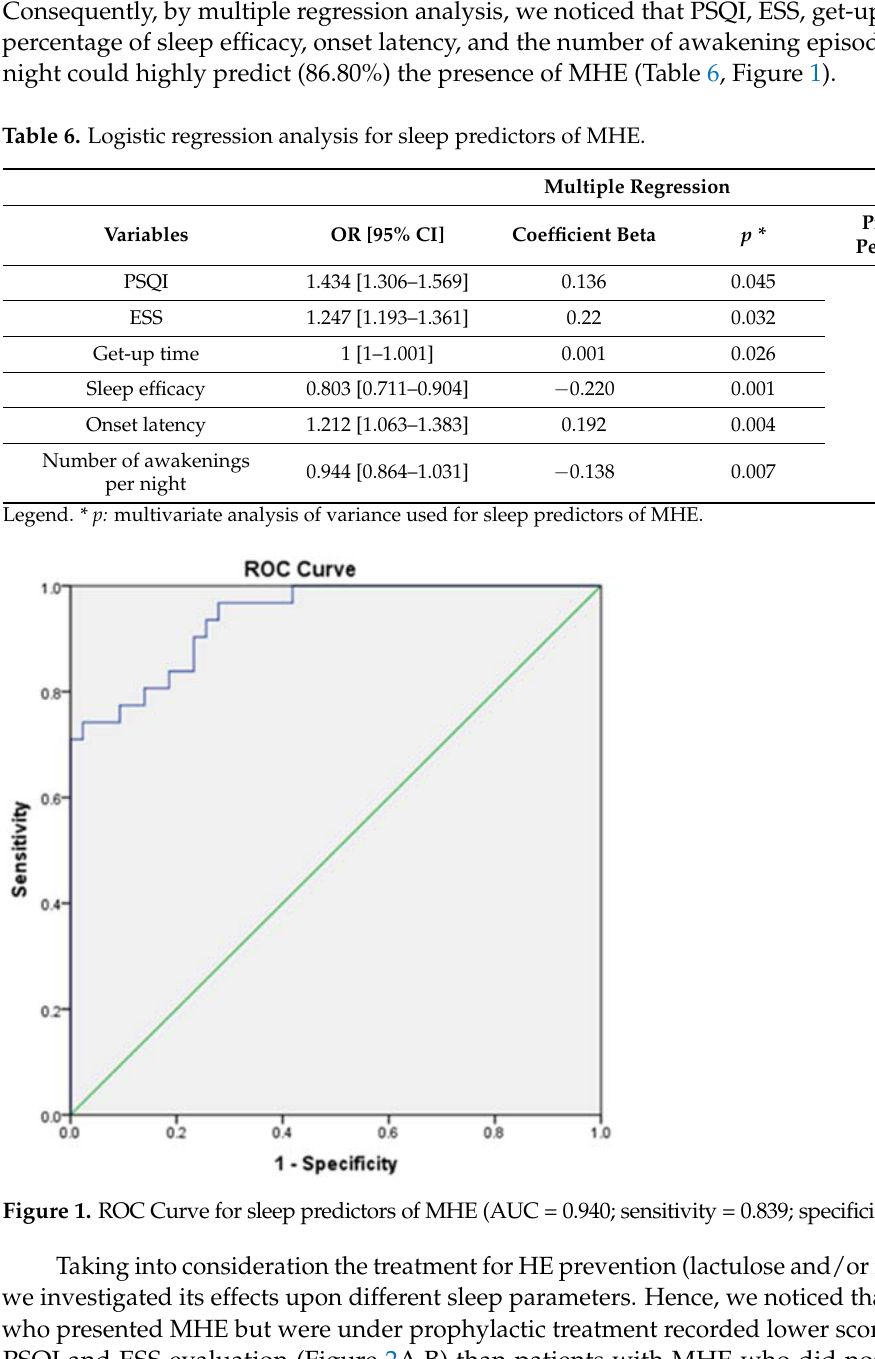
Figure 2. The relationship between MHE and self-reported questionnaires’ mean score: PSQI ( A ) and ESS ( B ) depending on the presence/absence of preventive treatment for HE. Legend. PSQI, Pitts- burgh Sleep Quality Index; ESS, Epworth Sleepiness Scale; HE, hepatic encephalopathy. In terms of actigraphic monitoring (Figure 3A,B), we noticed that sleep efficacy in patients with MHE was higher among patients undergoing prophylactic treatment com- pared to those who were taking no treatment for HE prevention (77.56 ± 4.17 vs. 75.67 ± 3.69). Moreover, patients with MHE who were under treatment had fewer awakenings